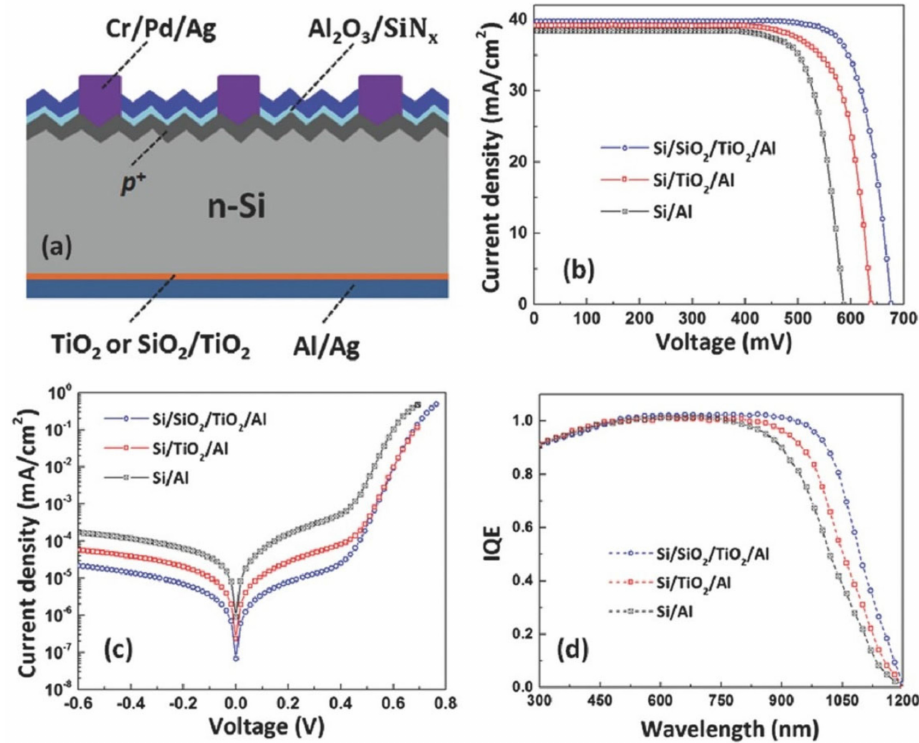
Figure 8. ( a ) Schematic diagram of hybrid n-type c − Si solar cell with full area TiO 2 or SiO 2 /TiO 2 rear contact and diffused front junction; ( b ) current density − voltage characteristics of three devices under illumination; ( c ) dark current density − voltage characteristics of three devices; ( d )